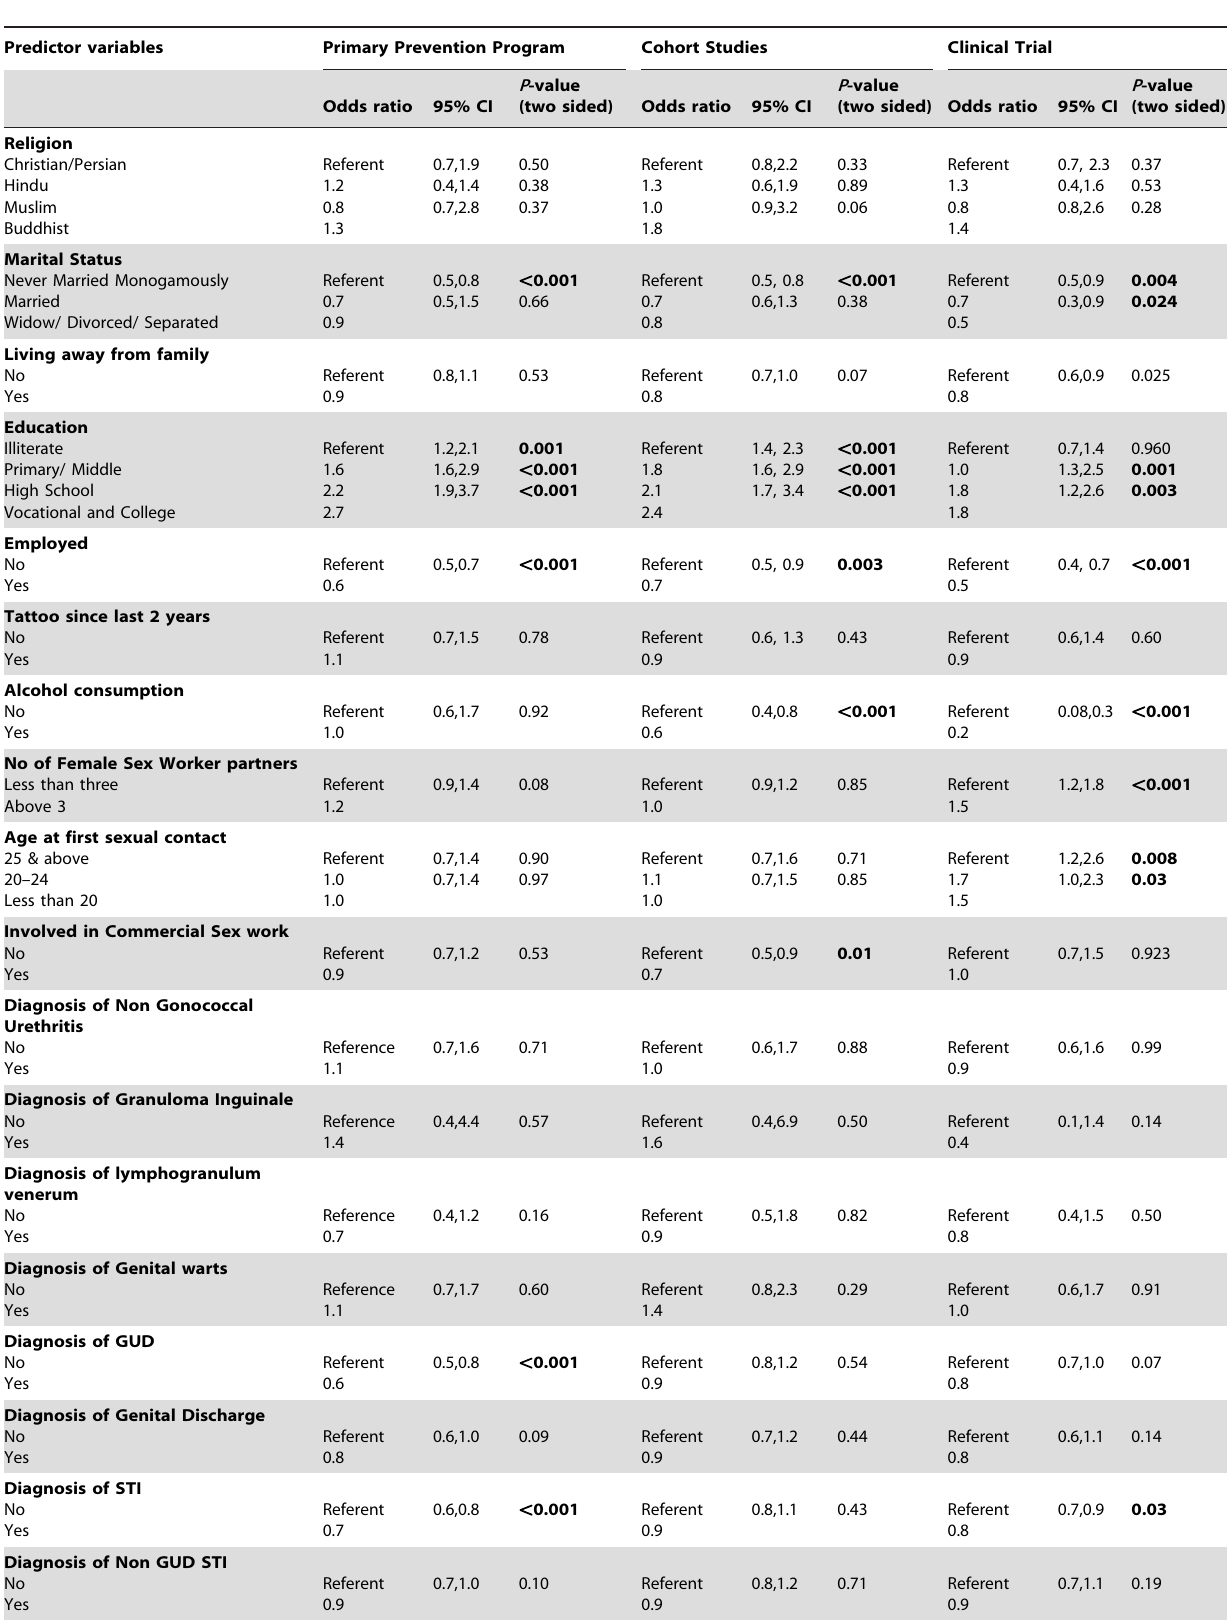
Table 2. Univariate analysis of Predictors of Retention in three modeled